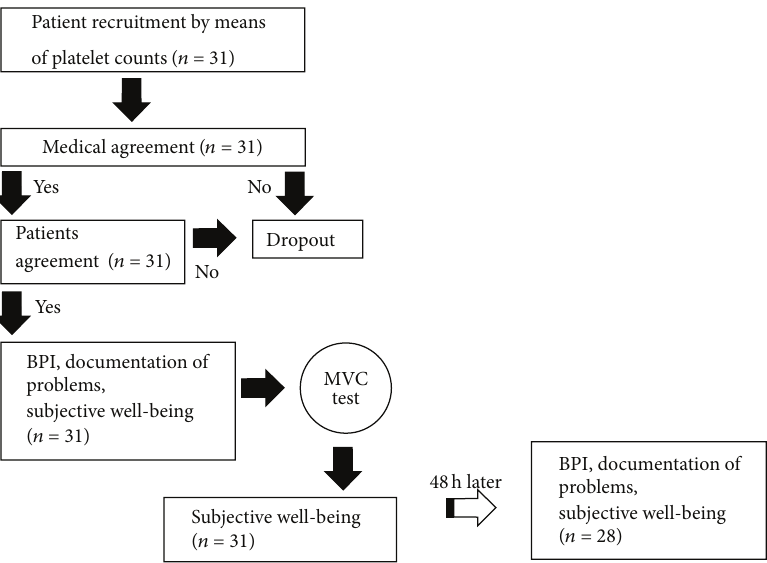
Figure 1: Patient